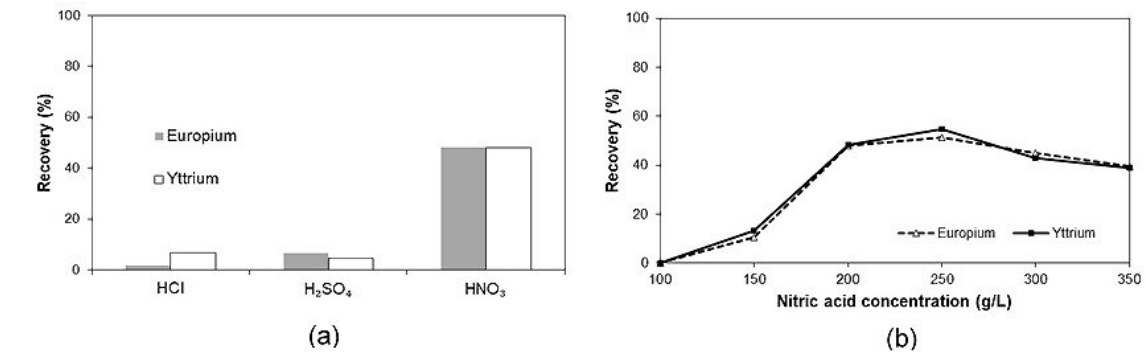
Figure 1. ( a ) Recovery of europium and yttrium with different leaching agents after 24 h of stirring and 10% of solids; ( b ) Recovery of europium and yttrium at different concentrations of HNO 3 (10% of solids and 24 h of agitation).